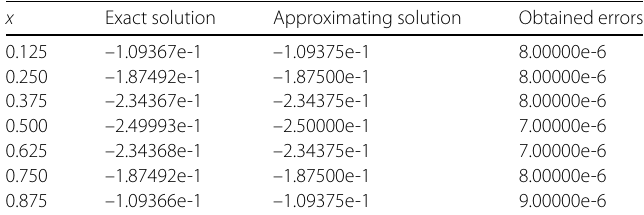
Table 4 Comparison of solutions obtained by the presented method with the exact solution of Example 2 while n = 128